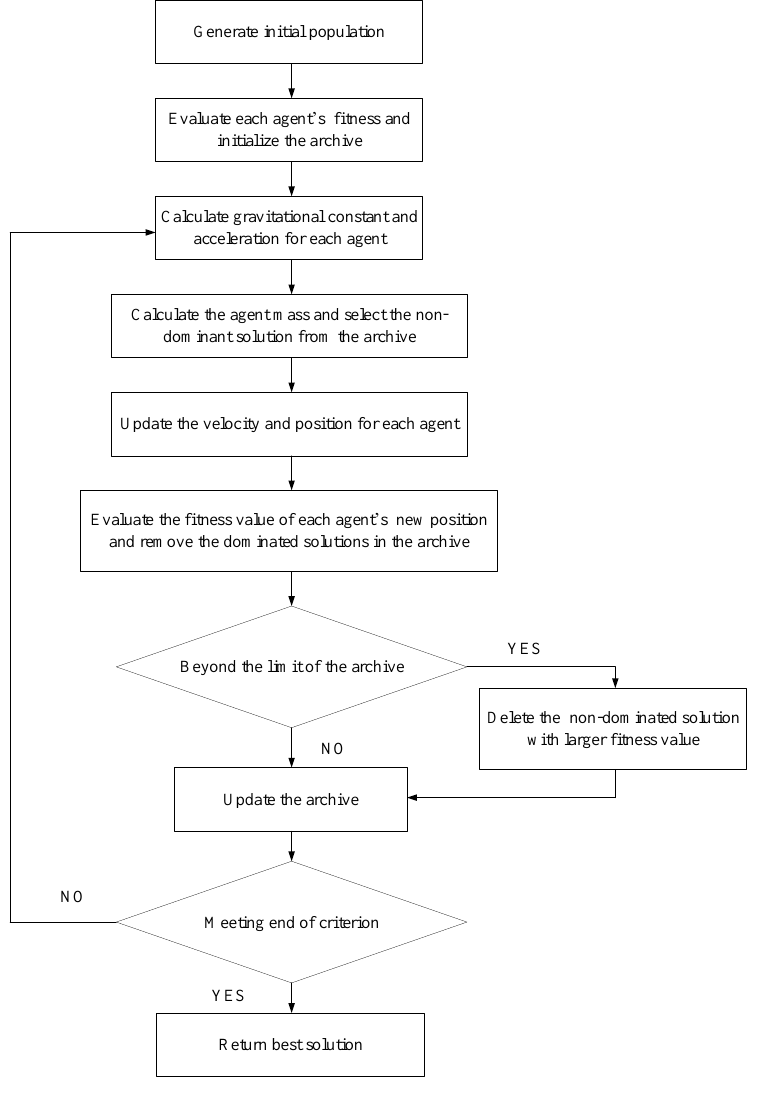
Figure 8. Flowchart of the multi-objective gravitational search algorithm (MOGSA).